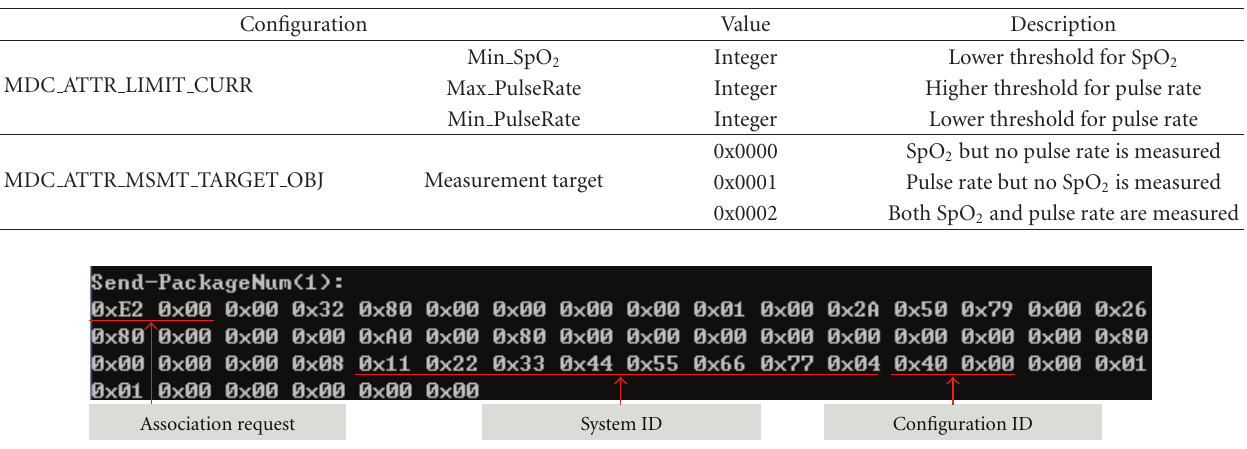
Table 2: System configurations of the pulse oximeter managed by PHD manager.